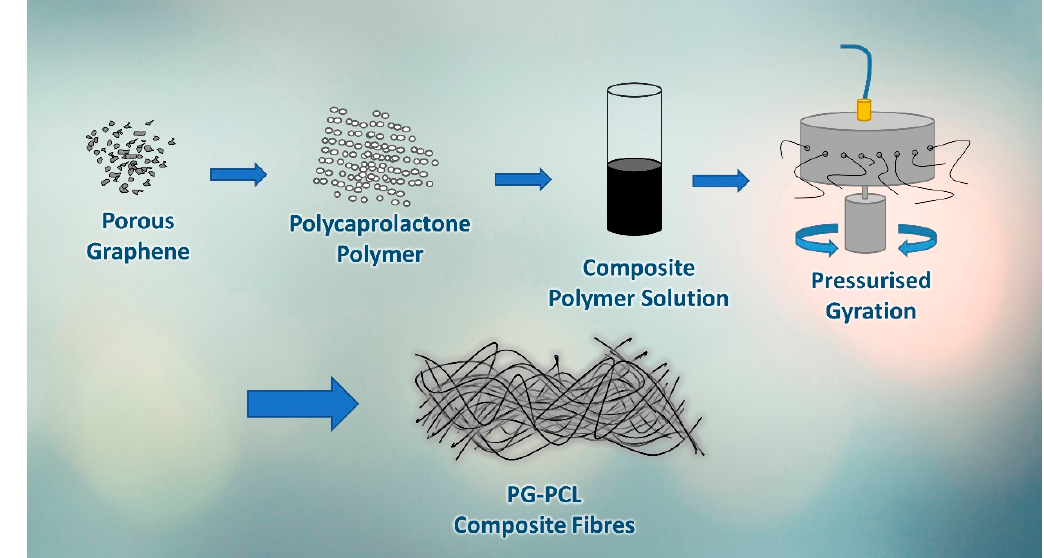
Figure 2. Schematic diagram representing major steps in the production of porous graphene (PG) composite polymer fibres.